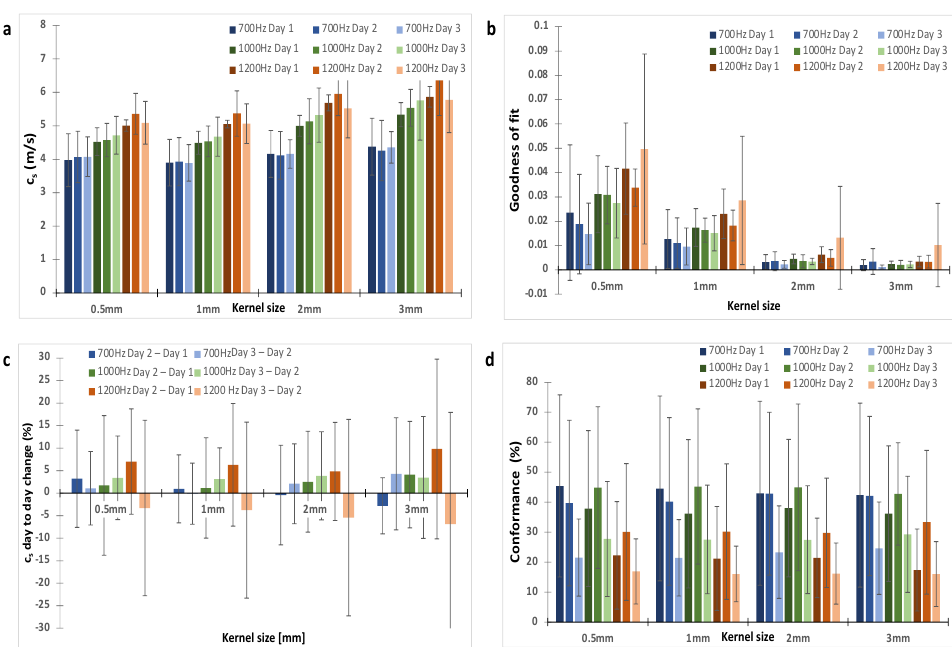
Figure A1. The choice of a 2 mm kernel dimension was based on the analysis of the shear wave speed (c s ), Goodness of Fit and repeatability for kernel sizes of 0.5, 1, 2 and 3 mm. ( a ) shows shear wave speed was similar for all kernel sizes. ( b ) On average, GoF increased with vibrational fre- quency and decreased with kernel size. ( c ) the repeatability was assessed using the percentage change in c s between repeat measurements acquired 24 hours apart. ( d ) The conformance, which was the percentage of vibrational energy detected at the shear wave drive frequency given, varied little with kernel size as expected because it is assessed at the centre of the kernel. A kernel dimen- sion of 2 mm offered good repeatability and small GoF error. The data shown are for one shaker. Trends were similar for data acquired with two shakers.